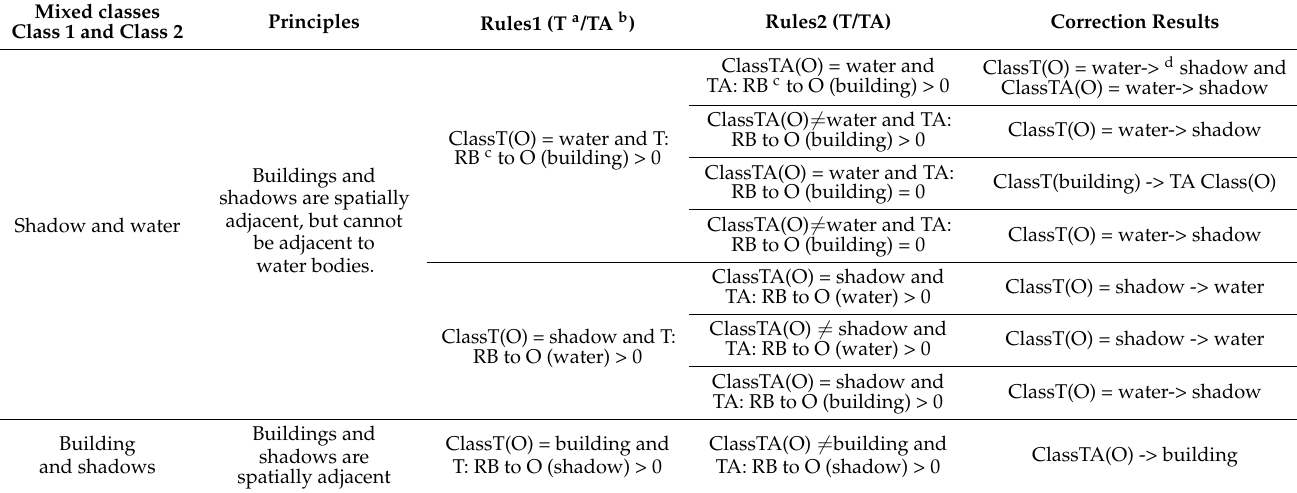
Table 3. Post-processing of classification based on spatiotemporal expert